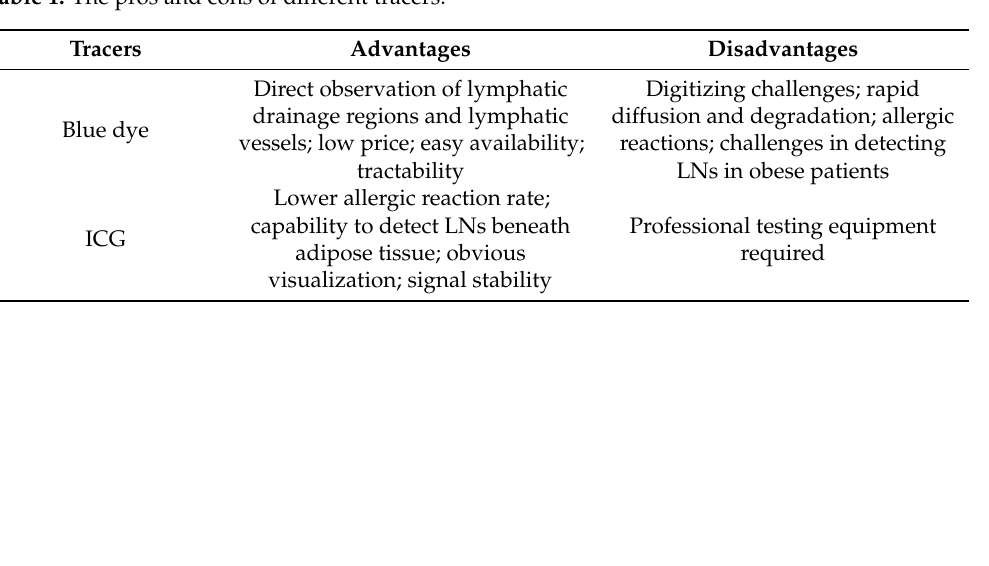
Table 1. The pros and cons of different